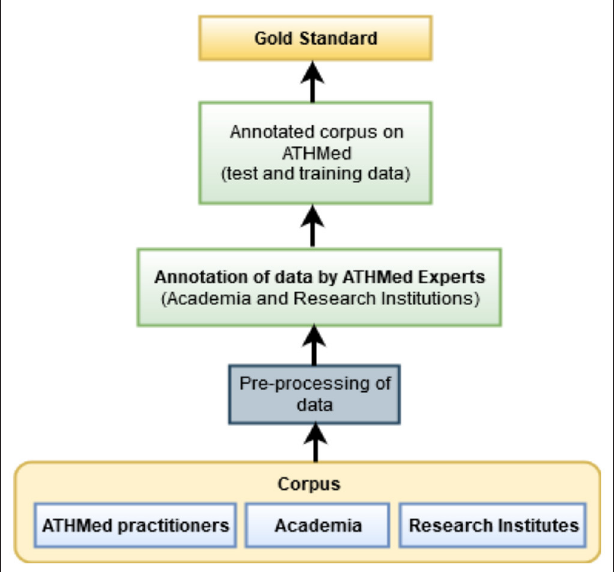
FIGURE 3 | Data sources, preprocessing, and annotation process for